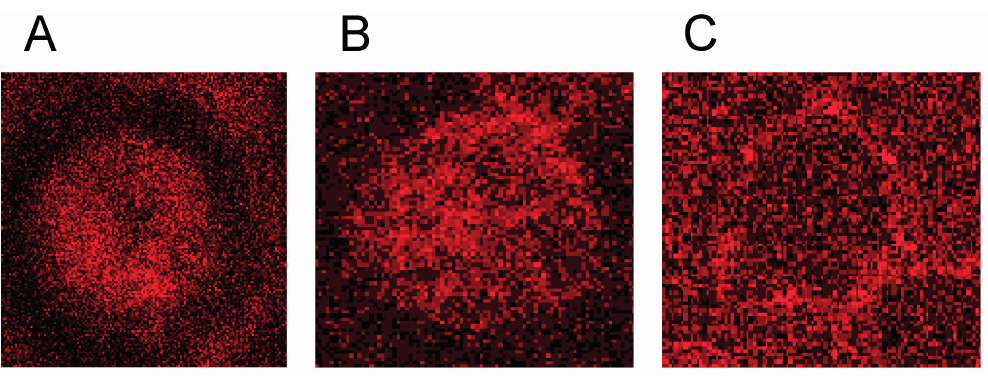
Figure 18. Representative erythrocytes stained with antibodies against band 3 (reprinted from reference [21]). ( A ) erythrocyte suspended in autologous plasma; ( B ) erythrocyte suspended in Iodixanol/plasma mixture (30% v / v ); ( C ) erythrocyte suspended in Iopromide/Plasma mixture (30% v / v ) (Primary magnification: 1:63; zoom factor